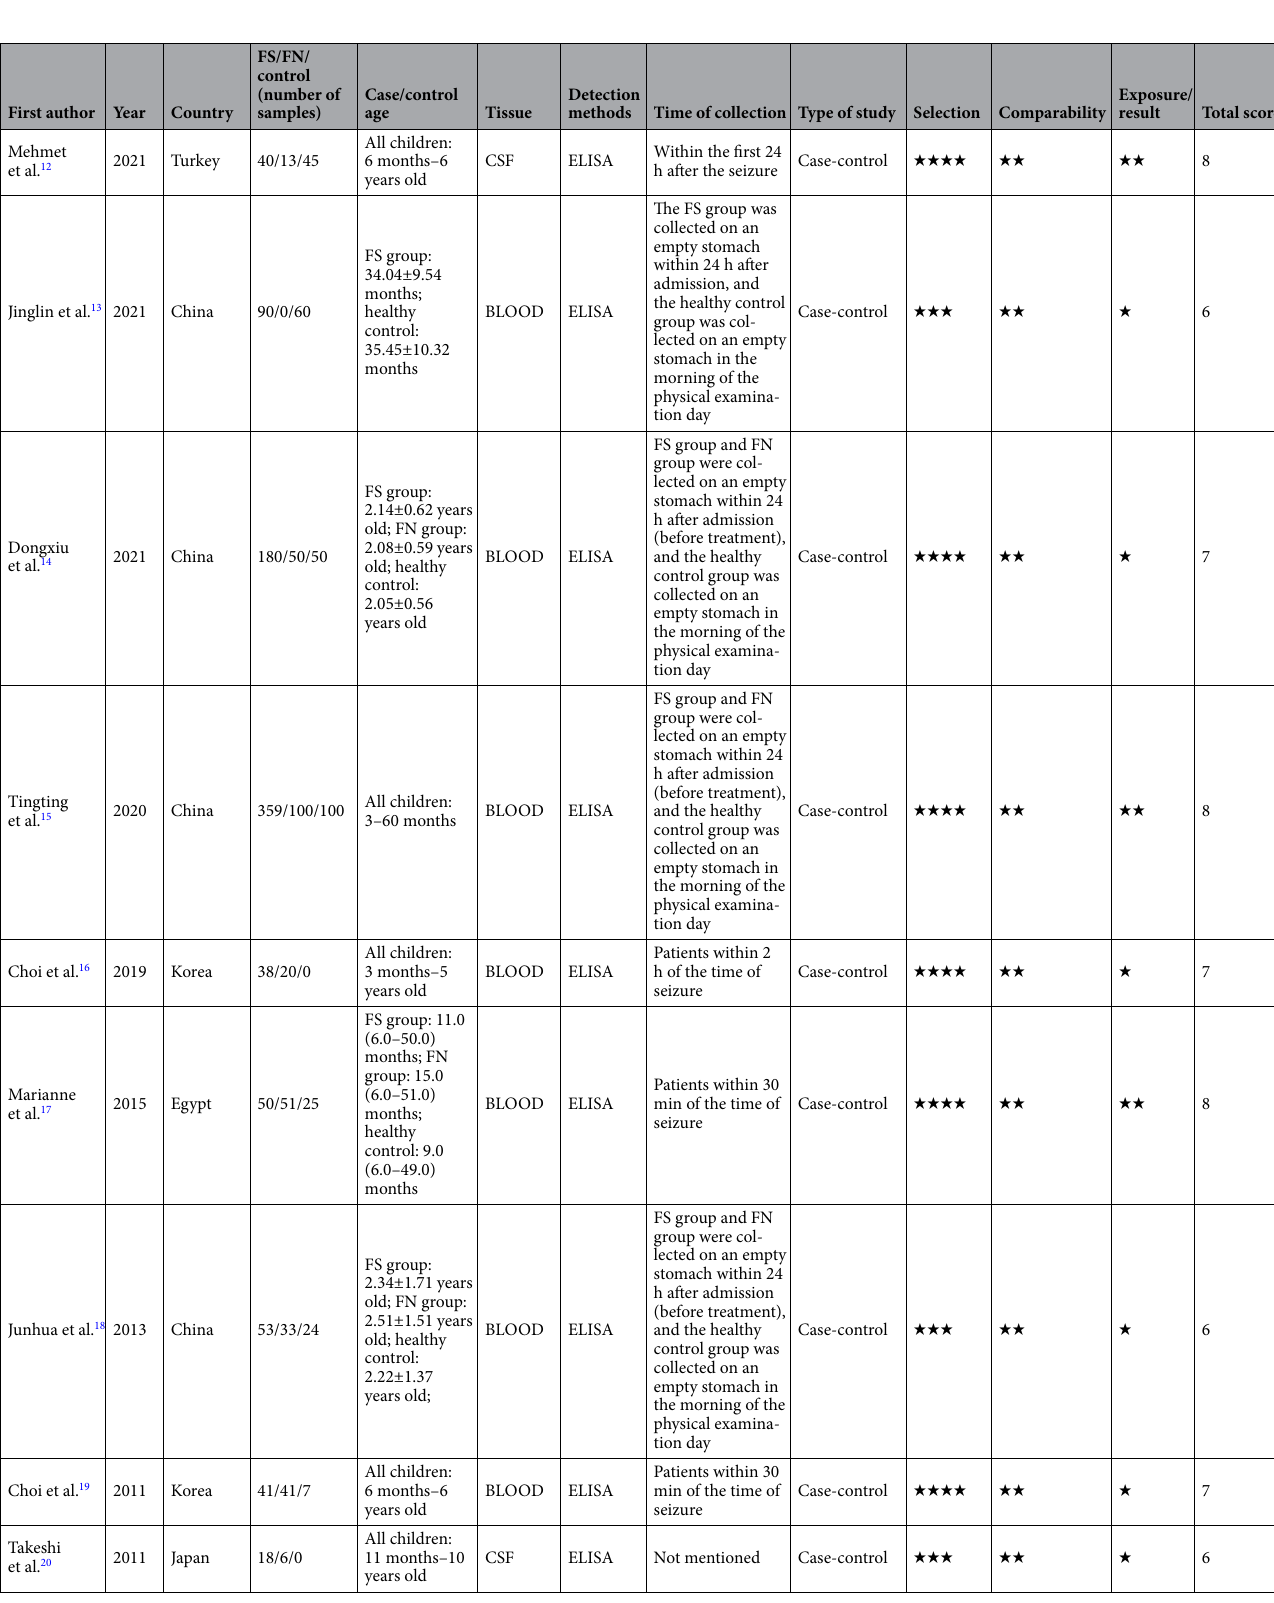
Table 1. Characteristic of all included literature. FS febrile seizures, FN fever but no convulsion, CSF cerebrospinal fluid, ELISA enzyme-linked immunosorbent